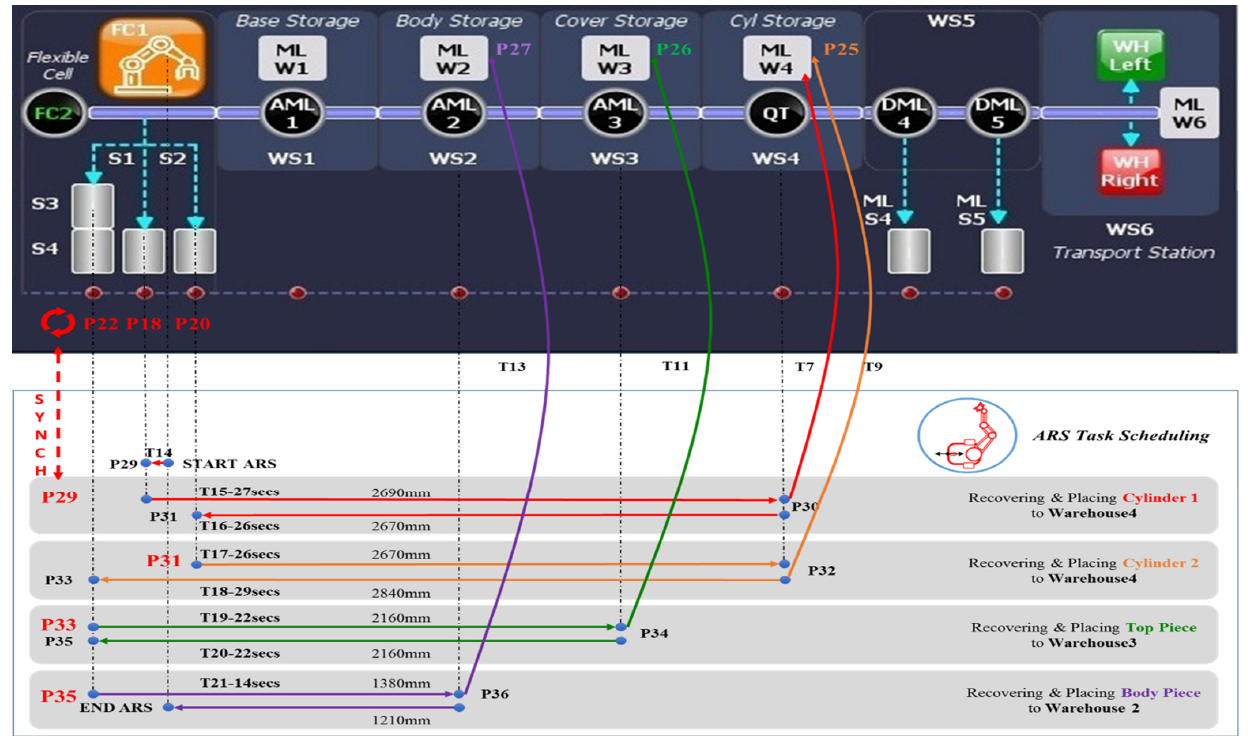
Figure 17. ARS task scheduling for repair/replace Cylinder 1.